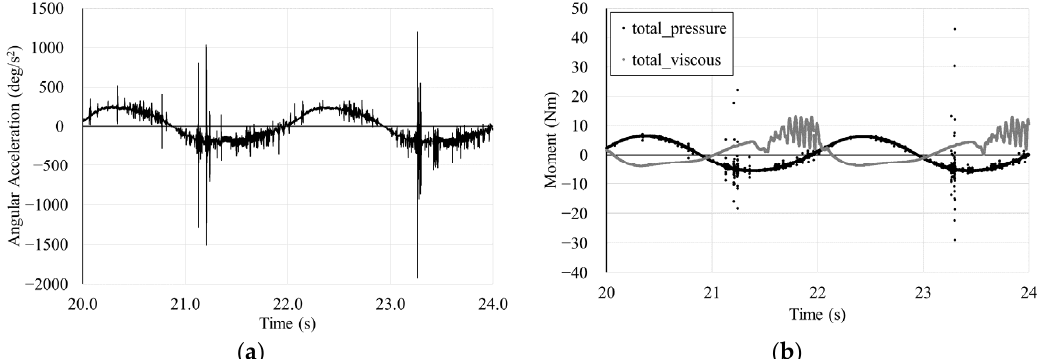
Figure 8. ( a ) Angular acceleration and ( b ) total pressure and viscous moments of the flap-type wave energy converter.